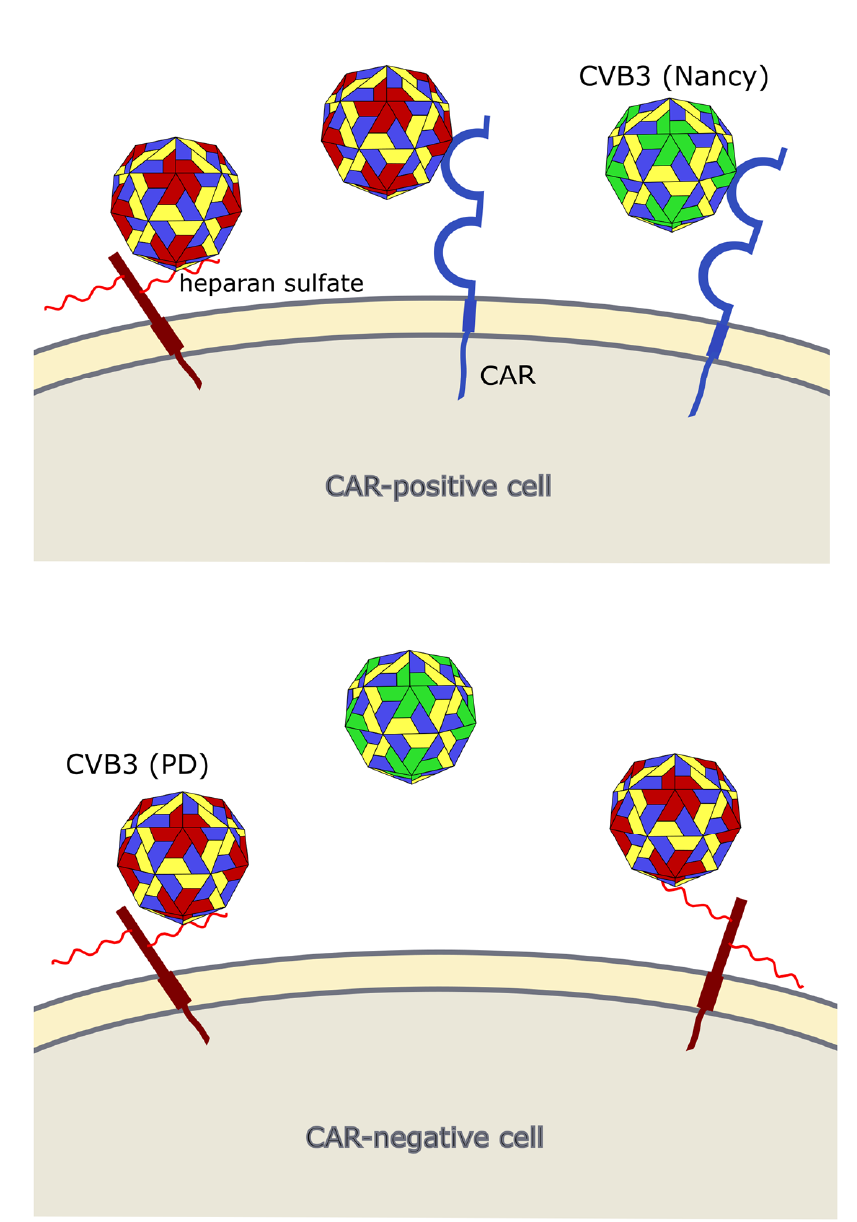
Figure 4. Interaction of CVB3 with cellular receptors. The prototype CVB3 strain Nancy uses CAR for cell entry, whereas the CVB3 variant PD can infect cells via N - and 6- O -sulfated heparan sulfates and CAR. Upper panel : CAR-positive cells can be infected with PD and the Nancy strain. Lower panel : CAR-negative cells cannot be infected with the Nancy strain, but with PD when N - and 6- O -sulfated heparan sulfates are expressed on the cell surface.